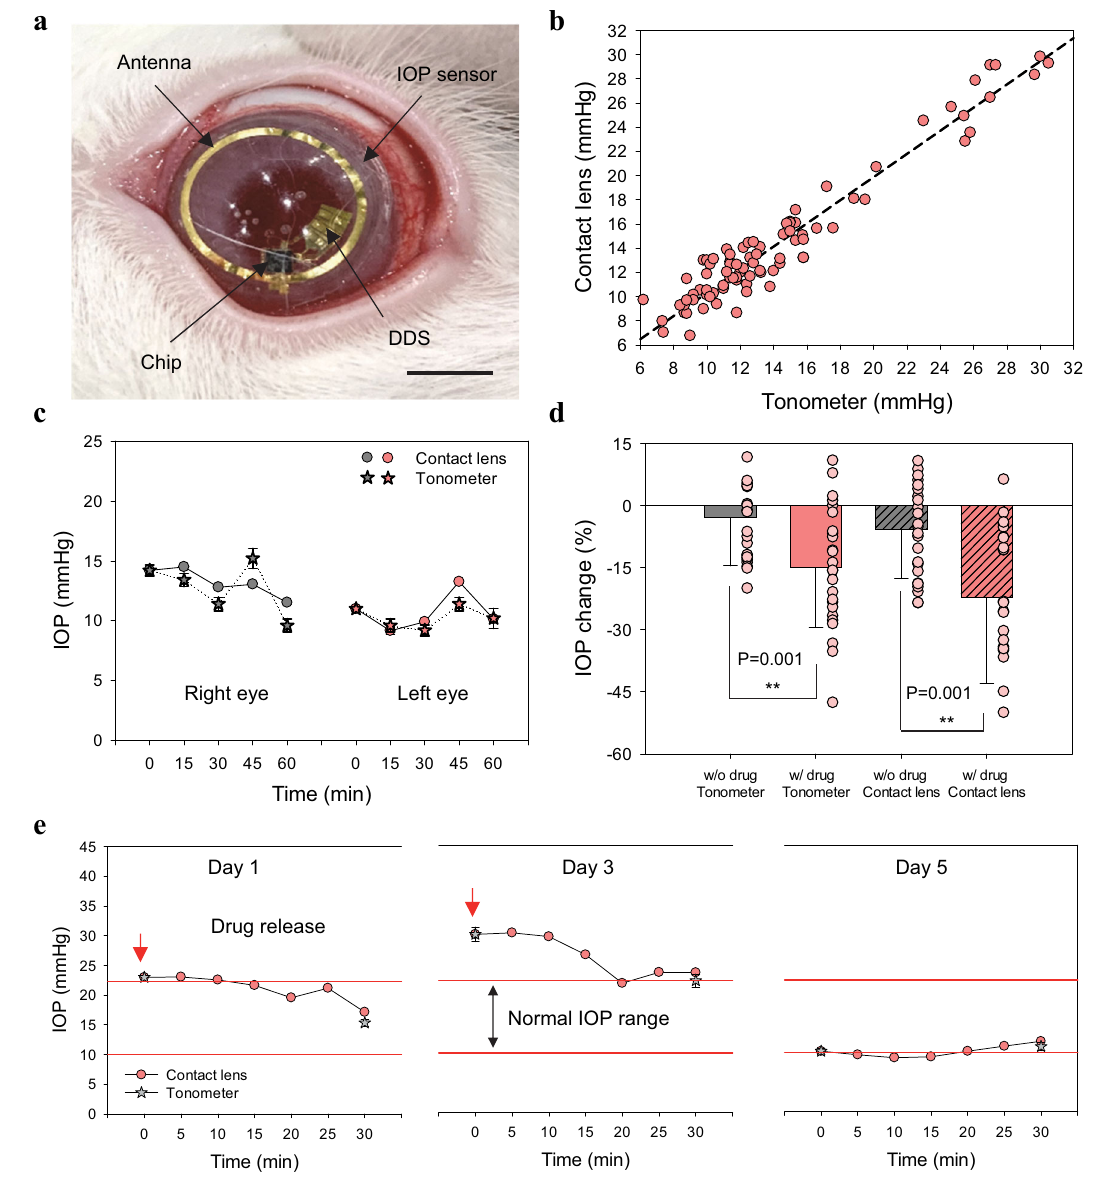
Fig.6|InvivoIOPcontrolwithatheranosticsmartcontactlens.a Photo-image of a fully integrated theranostic smart contact on rabbit ’ s eye (scale bar, 5.5mm). b The correlation of IOP measured with a smart contact lens and a tonometer ( R 2 =0.94). c IOP monitoring of right and left eyes with a smart contact lens and a tonometer ( n =3 independent experiments for tonometer). d The IOP change by timolol released from the smart contact lens ( n =25 independent experiments,